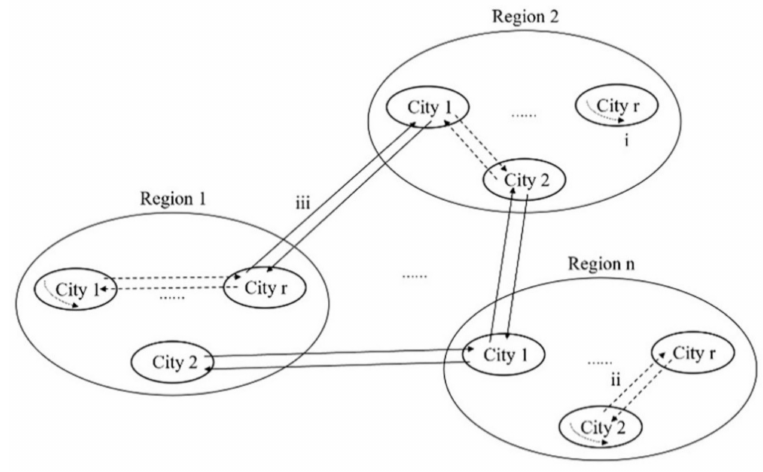
Figure 1. A schematic diagram of the relevant concepts. Line i represents inner-city transport, line ii and line iii represent inter-city transport, and line iii also represents inter-regional transport.